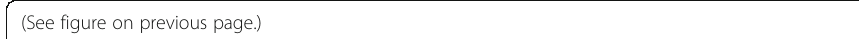
Table 3 Summary of the features of the Fig. 3 fits Region R 2 SUVR intercept Global 0.92 Anterior cingulate 0.88 Anterior ventral striatum Insula Lateral temporal Orbital frontal Parietal Poster cingulate 0.88